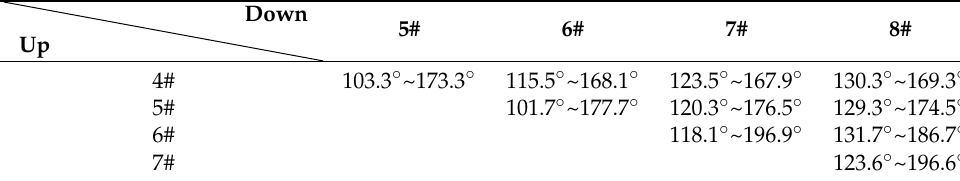
Figure 8. Schematic diagram of wind turbine layout. Table 3. The influence sector of upstream wind turbine on downstream wind